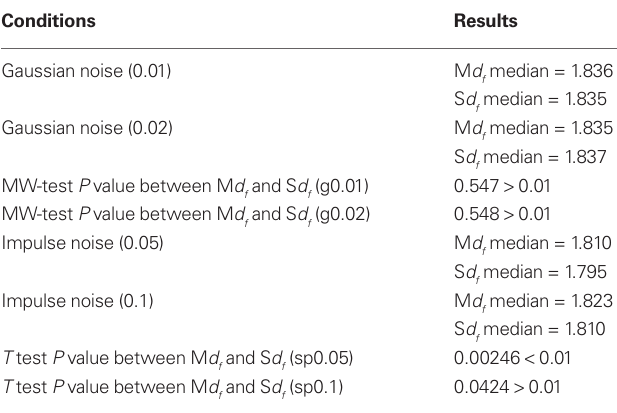
calculation by TeM images. f